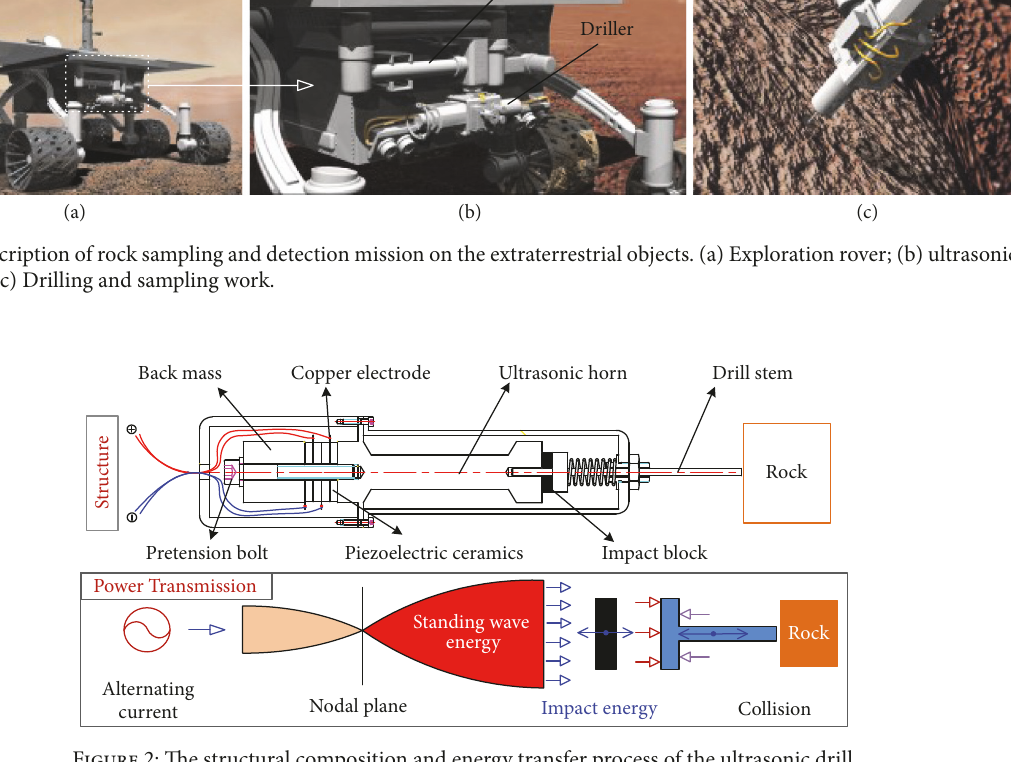
Figure 2: The structural composition and energy transfer process of the ultrasonic